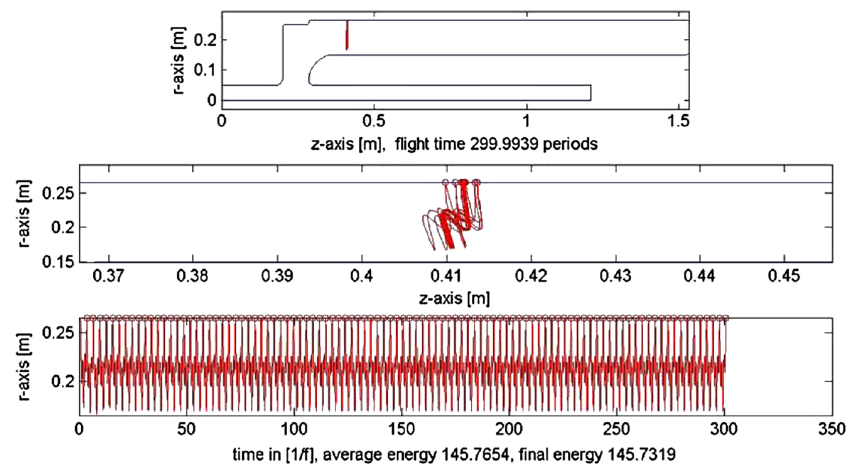
FIG. 11. (Color) Multipacting in the outer conductor with a bigger radius ( > 25 cm